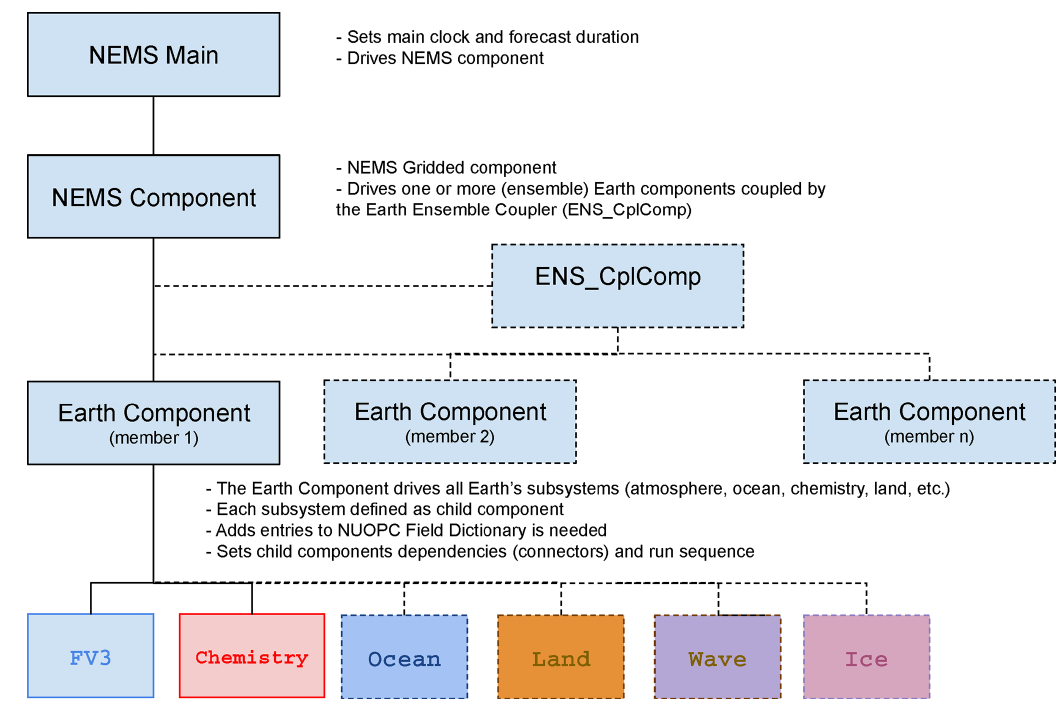
Figure 1. Diagram showing the components within the NEMS